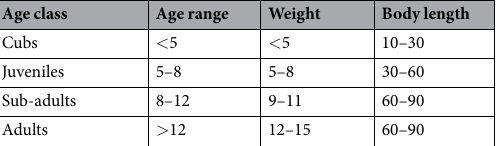
Table 1. Age range (month), weight (Kg) and body length (cm) parameters for each porcupine age class used to assess the age class of porcupine recorded in